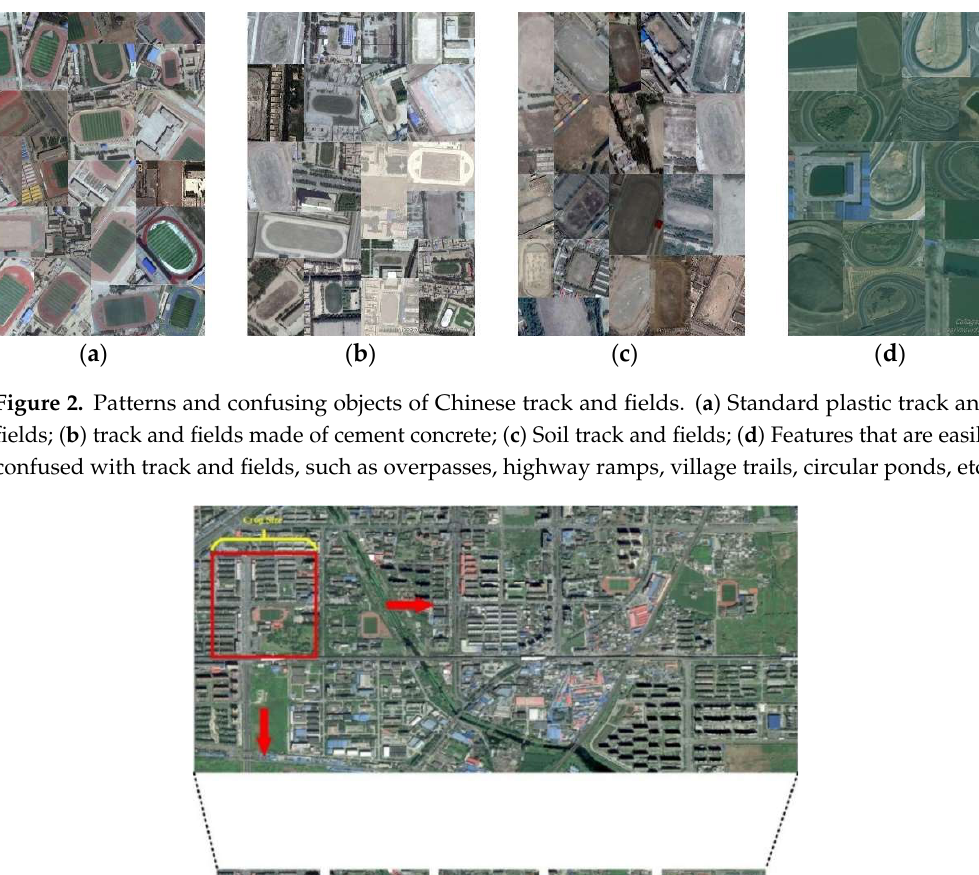
Figure 2. Patterns and confusing objects of Chinese track and fields. ( a ) Standard plastic track and fields; ( b ) track and fields made of cement concrete; ( c ) Soil track and fields; ( d ) Features that are easily confused with track and fields, such as overpasses, highway ramps, village trails, circular ponds, etc.